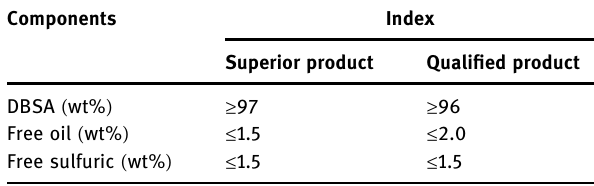
Table 1: Physicochemical indices obtained via GB/T 8447 - 2008